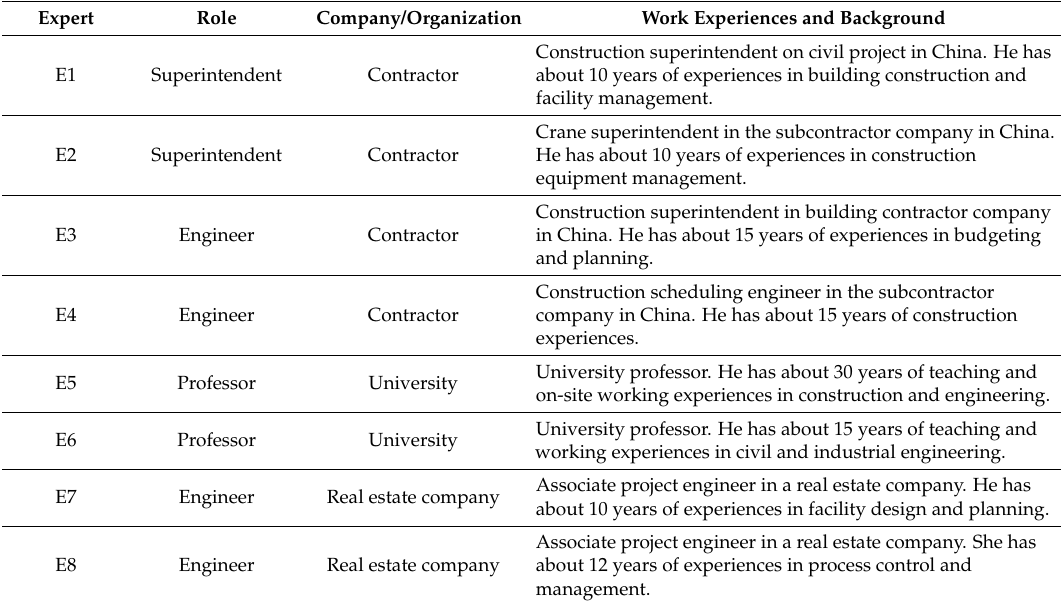
Table 7. Experiences and background of the selected experts.